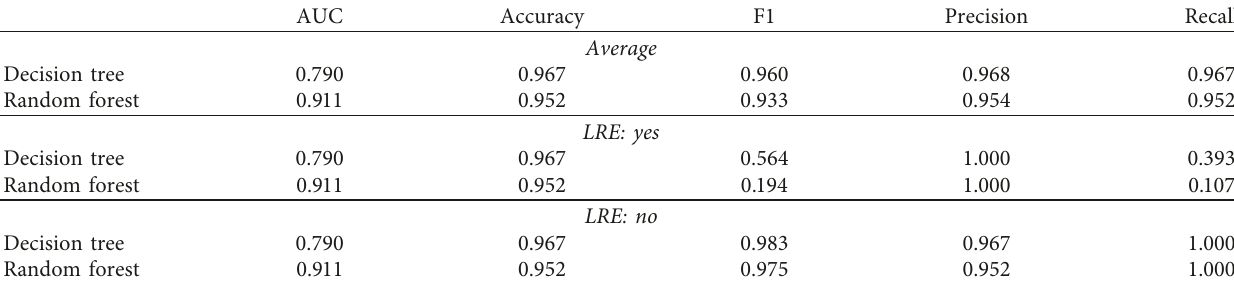
Table 3: Performance of decision tree and random forest classifiers in predicting